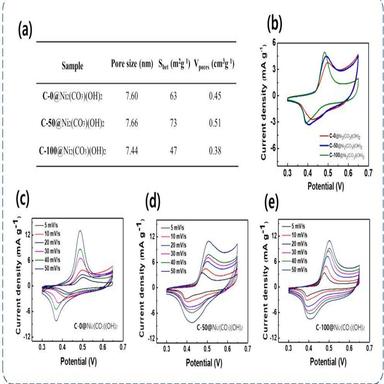
(a) BET measurements for the specific surface area, pore volume, and pore size of Ni2(CO3)(OH)2 and core-shell carbon@Ni2(CO3)(OH)2 compounds; (b) comparison of CV curves of the Ni2(CO3)(OH)2, C-50@Ni2(CO3)(OH)2, and C-100@Ni2(CO3)(OH)2 compounds at a scan rate of 10 mV s − 1 ; (c) CV curves of Ni2(CO3) (OH); (d) C-50@Ni2(CO3)(OH)2; (e) C-100@Ni2(CO3)(OH)2 compounds.